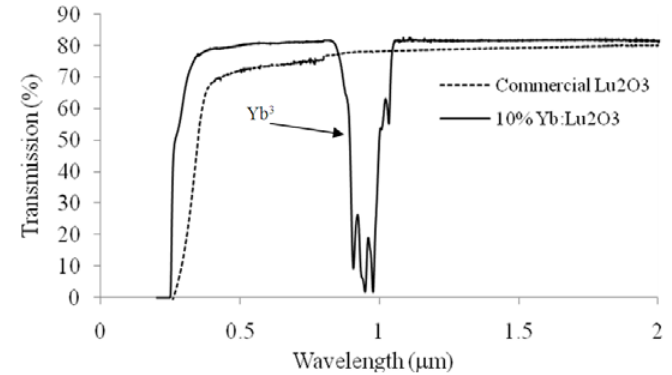
Figure 4. Transmission plot of the optically polished ceramics fabricated from our co-precipiated 10% Yb:Lu O and commercial powders, 2 3